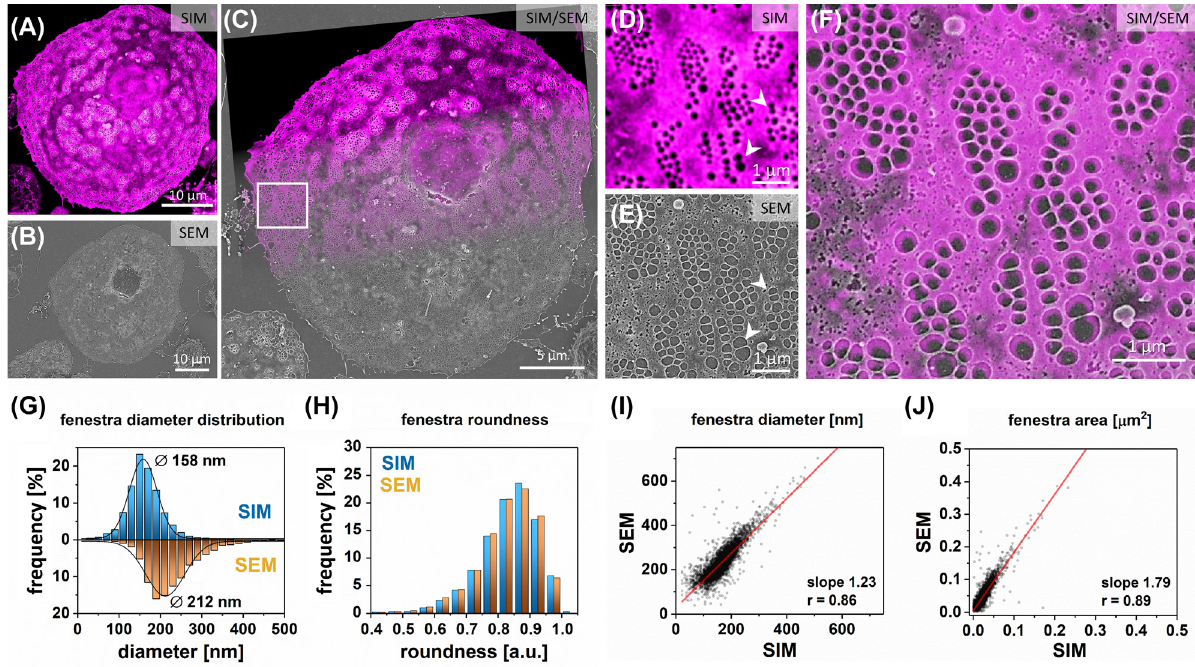
Figure 1: Correlative SIM and SEM